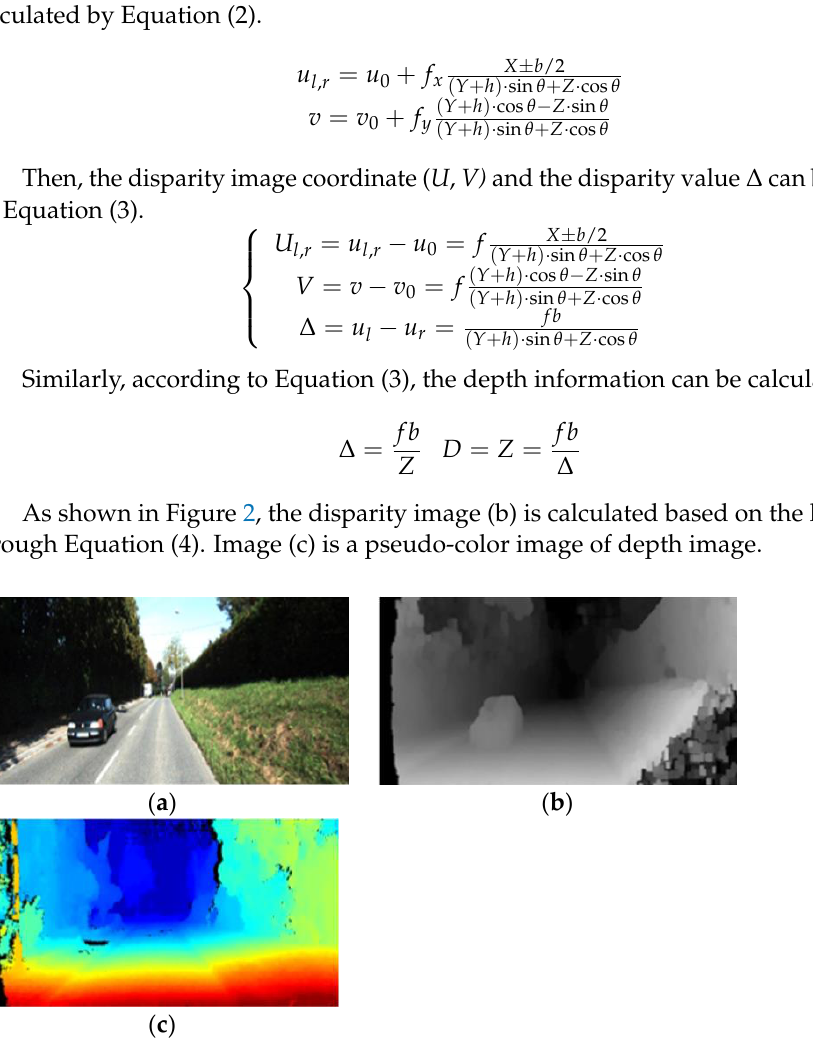
Figure 2. Disparity image calculated based on stereo vision system: ( a ) left image; ( b ) disparity image; and ( c ) pseudo-color image of depth image.